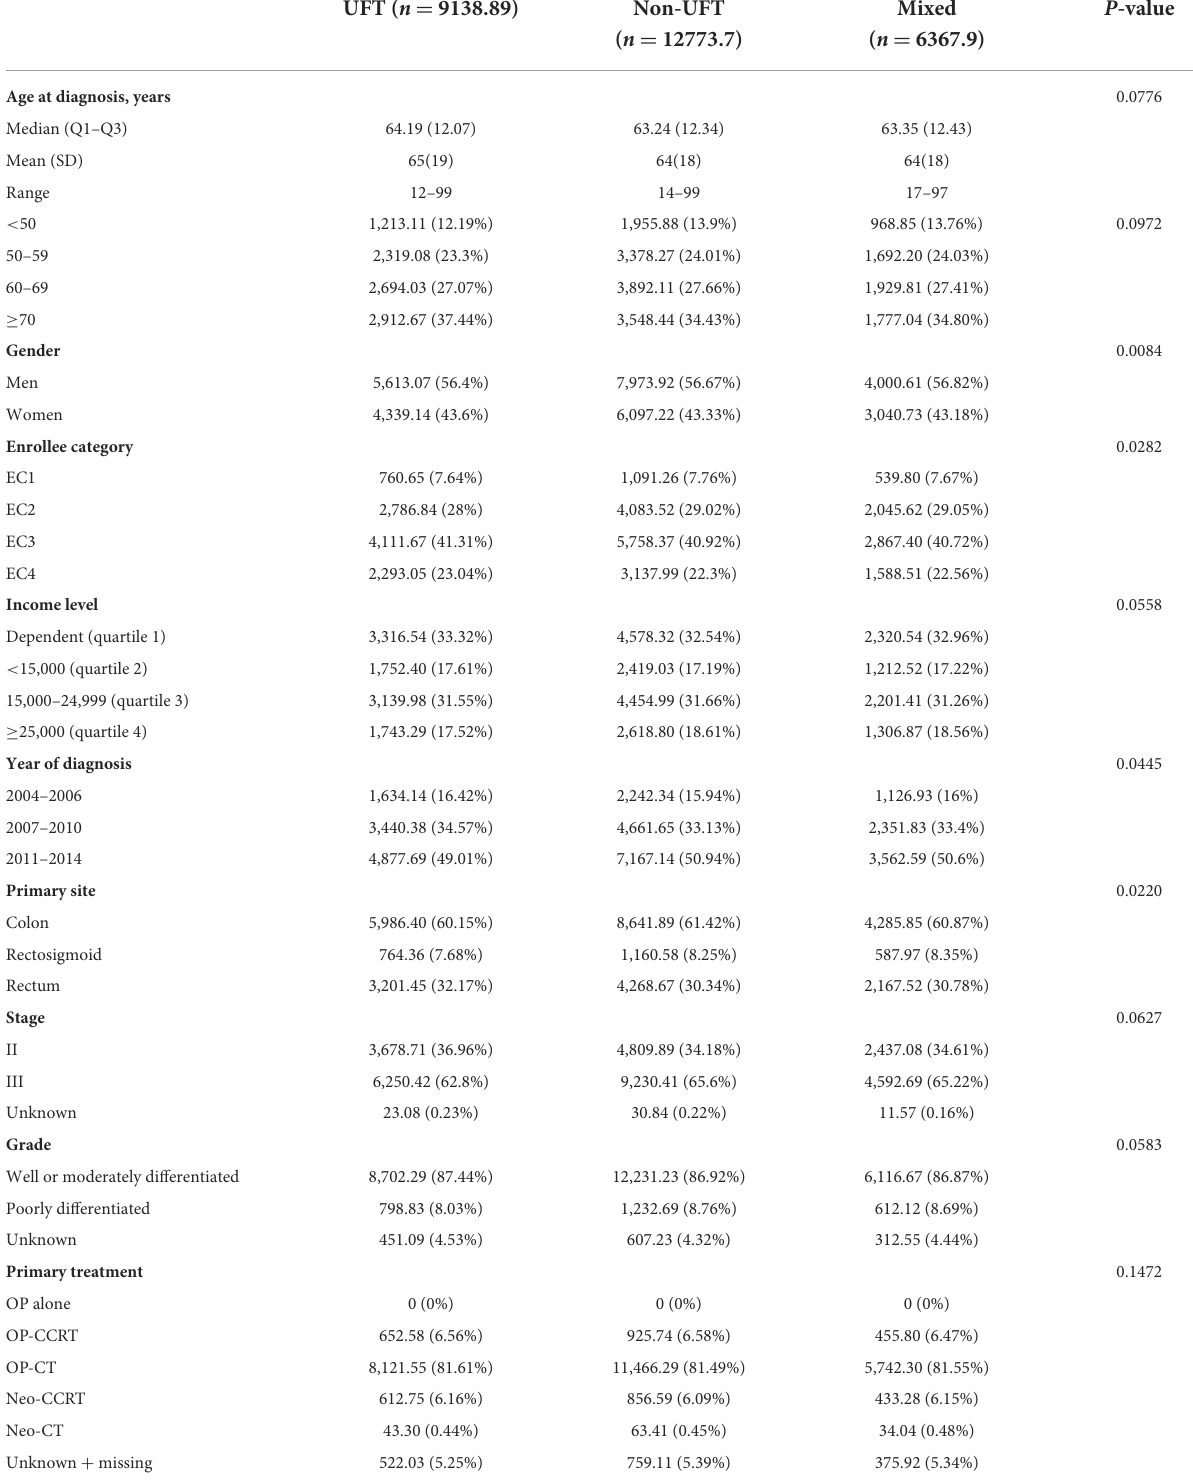
TABLE 2 Demographic, cancer, comorbidity, and medication characteristics among patients with stage II–III colorectal cancer after